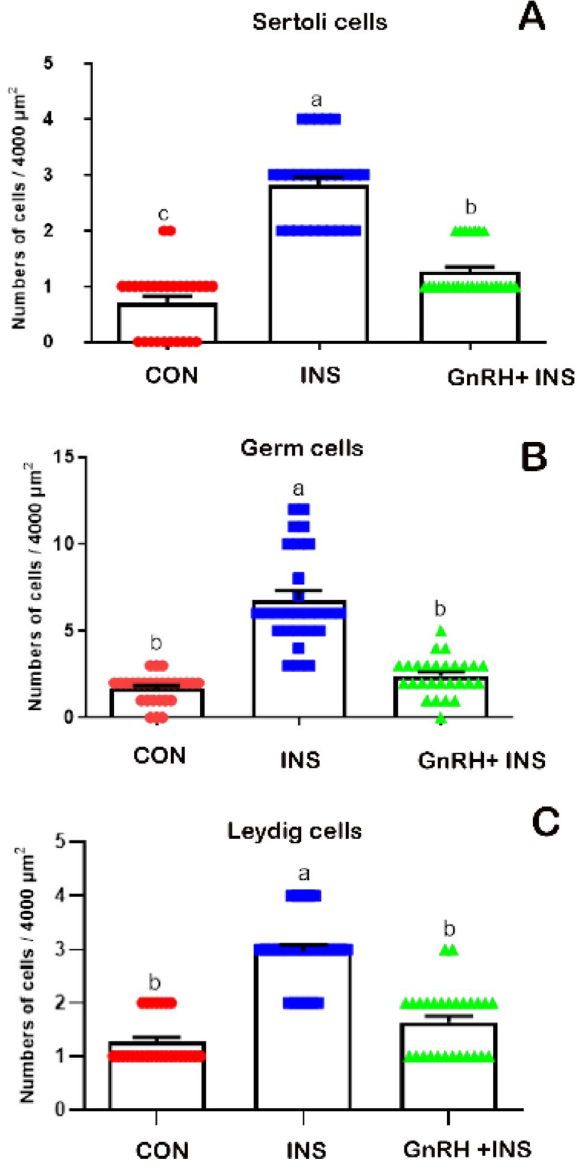
Figure 3. Numbers of apoptotic Sertoli ( A ), Germ ( B ) and Leydig ( C ) cells in seminiferous tubules of buck’s testis. Different letters indicate significant differences between the groups ( p < 0.05). Results are presented as mean ±